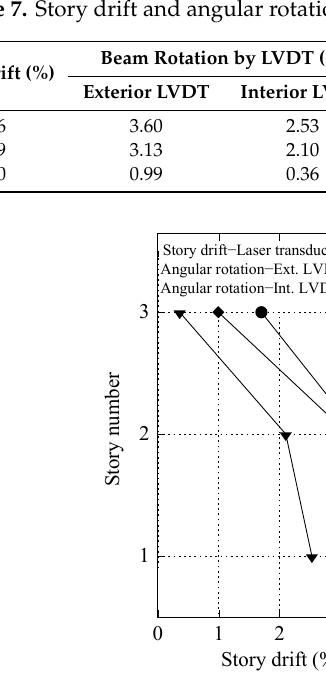
Table 7. Story drift and angular rotation of the hanging walls.